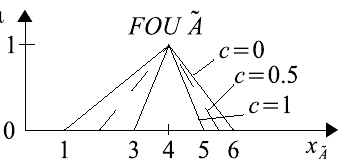
Figure 23. Triangular T2FN ˜ A defined by the Formula (42) shown in 2D space in the form of FOU . Figure 24 shows the inverse T2FN ˜ A − 1 in 3D space and Figure 25 in 2D space.